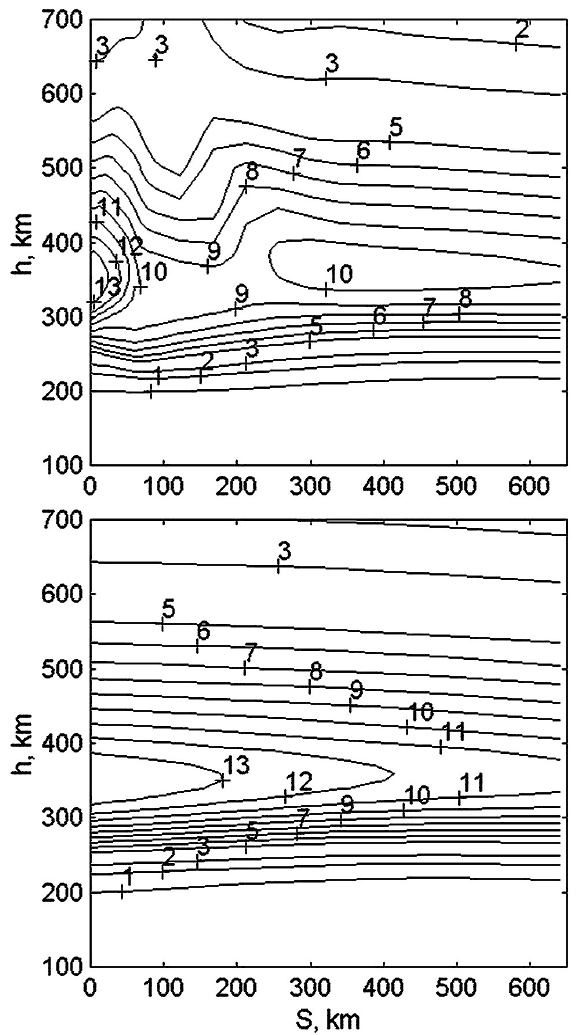
Fig. 8. The calculated isolines of the electron concentration (in units of 10 4 cm − 3 ) over the considered part of the convection trajectory obtained at night under natural conditions without HF heating (bot- tom panel) and on condition that the powerful HF wave has the frequency of 3.2MHz (top panel).